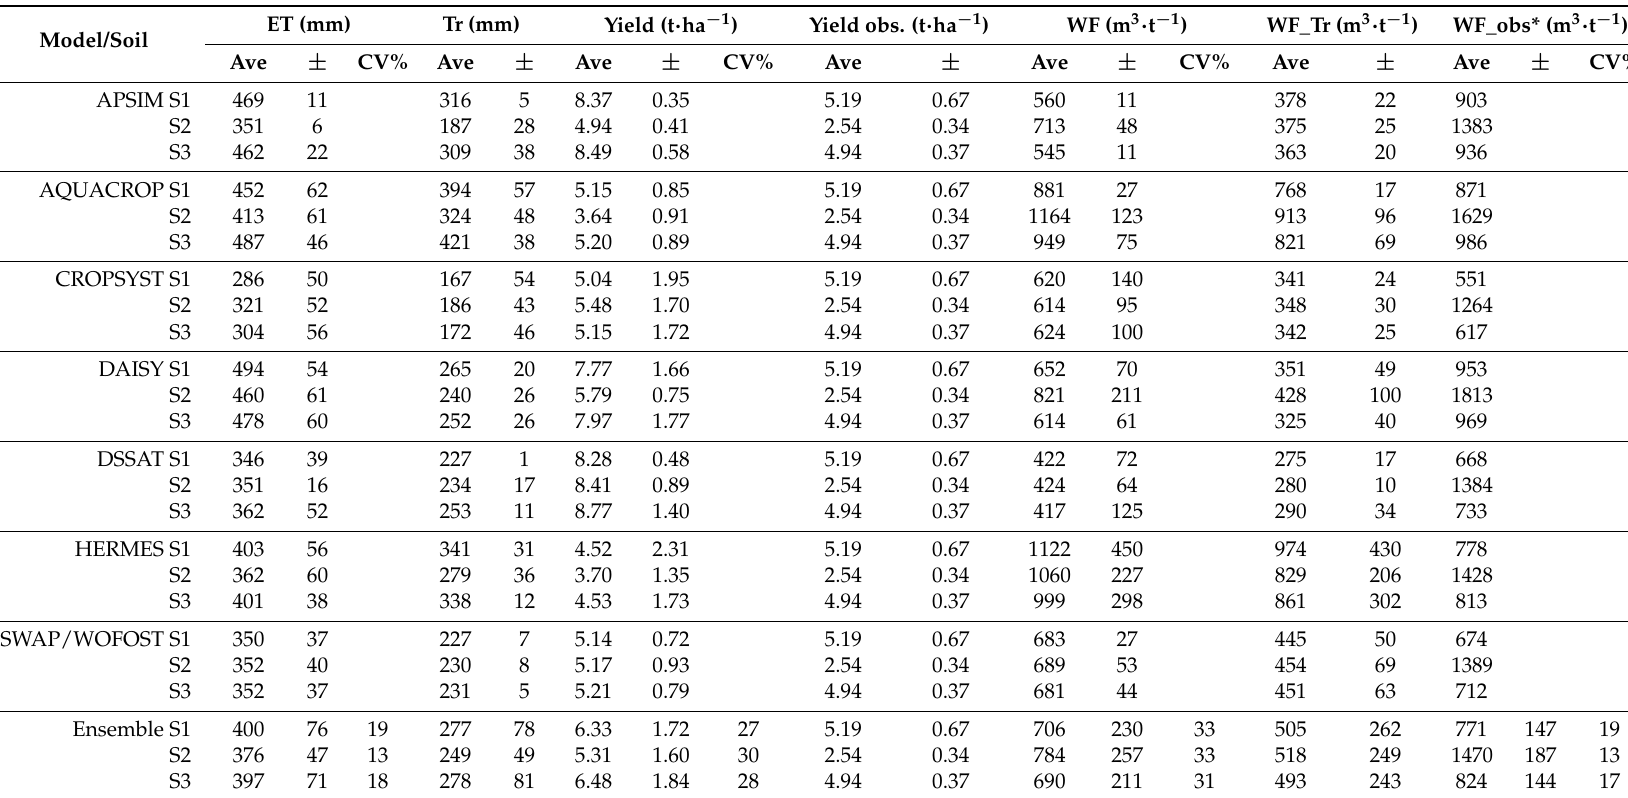
Table 3. Simulated actual evapotranspiration (ET), transpiration (Tr), grain yield (86% d.m.) and resulting water footprints based on ET (WF) and transpiration (WF_Tr) for winter wheat on three soils at Hirschstetten/Austria from different models. WF_obs* indicate water footprints calculated from simulated ET and measured yields. Ave is the average value, ± indicates the range of simulated values around the mean and the standard deviation of the ensemble mean, CV% is the coefficient of variation between models in